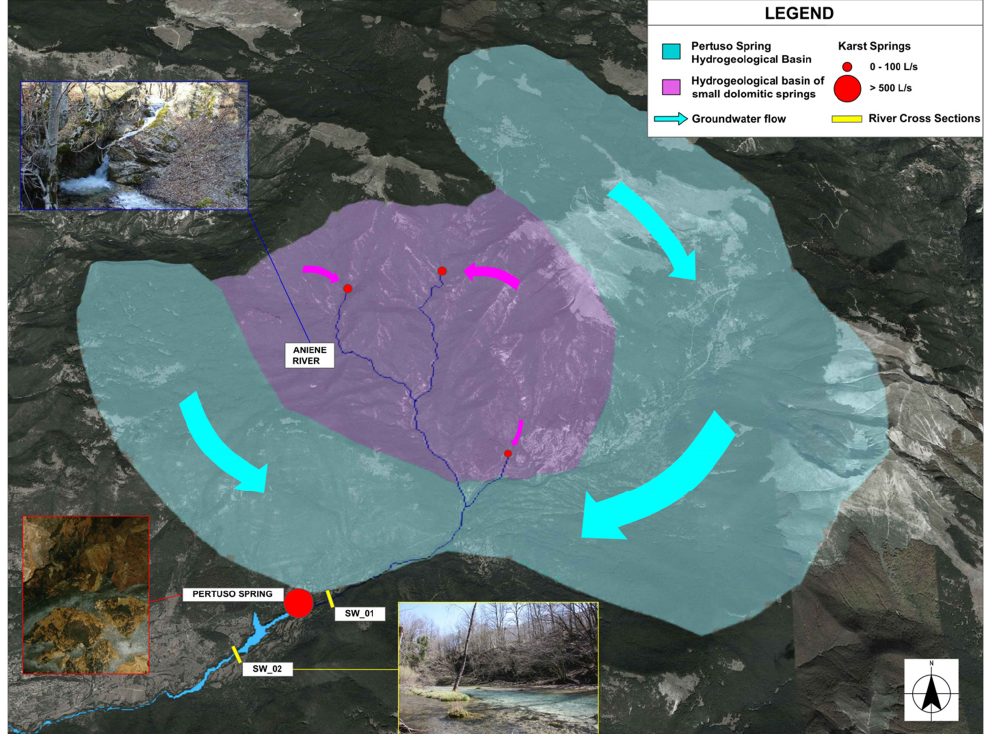
Figure 2. Hydrogeological basins of karst springs in the Upper Valley of Aniene River: in light blue the limestone reservoir feeding the Pertuso Spring, in purple the dolomitic one feeding upstream smaller springs.